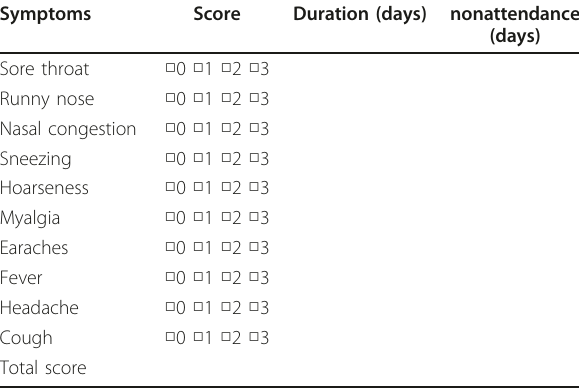
Table 2 Questionnaire for Influenza-Like Illness Symptoms